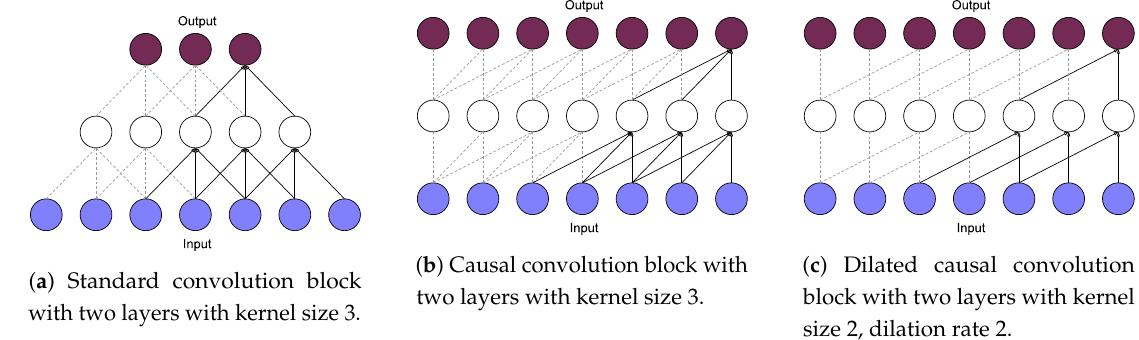
Figure 4. Differences between ( a ) standard convolutional network, ( b ) causal convolutional network, and ( c ) dilated causal convolutional